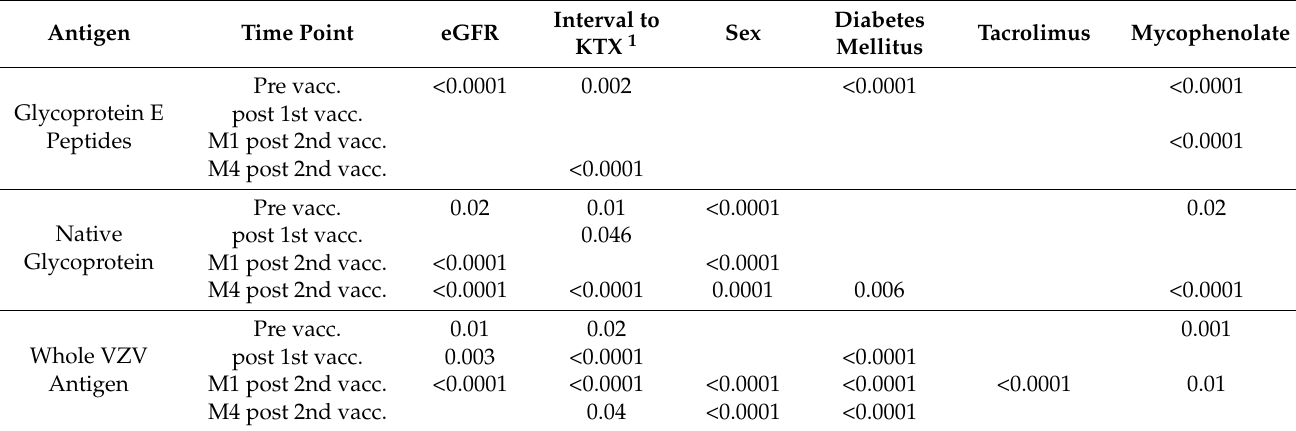
Table 5. Multivariate analysis of varicella–zoster virus (VZV)-specific ELISpot responses and clinical parameters in 29 kidney transplant recipients.